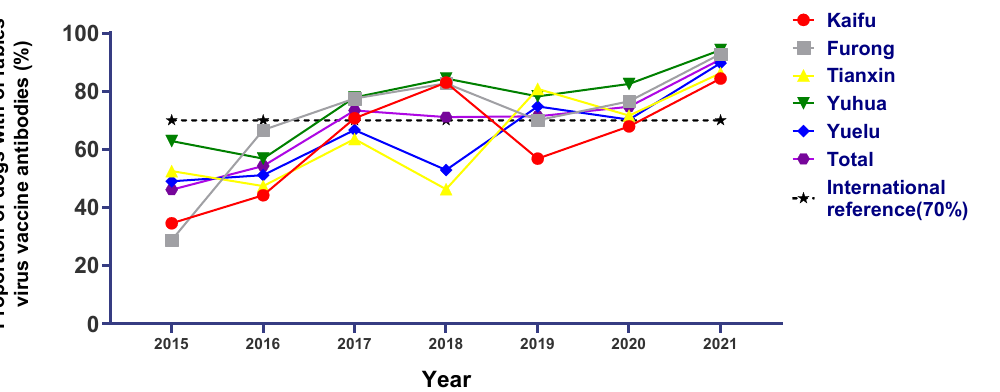
Figure 3. Proportions of seroconversion to vaccination against rabies virus over time in each urban area of Changsha, China, 2015–2021.